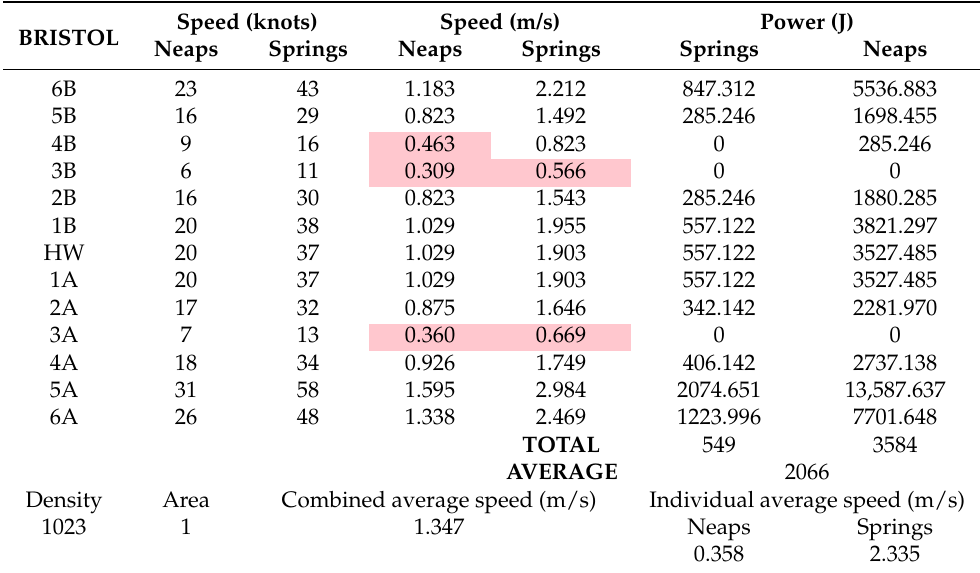
Table 5. Calculation process for Bristol tidal